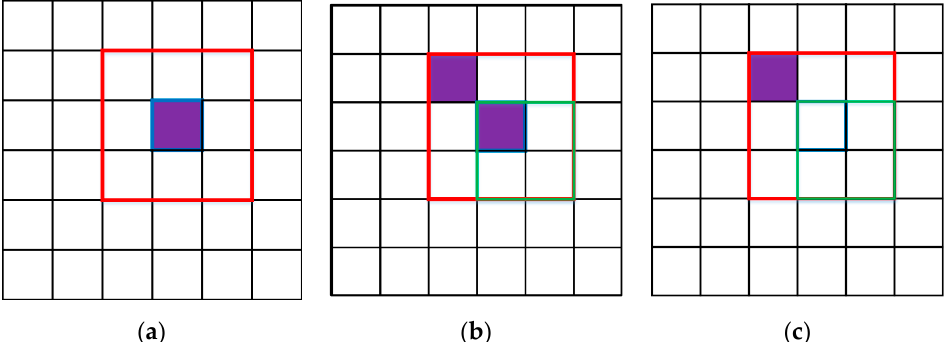
Figure 1. Analysis between the center test pixel and neighboring pixels in a single local window. The purple squares represent anomalous pixels, and the white squares represent the same category background pixels: ( a ) ideal distribution of neighboring pixels; ( b ) the neighborhood contains anomalous pixels; ( c ) the center pixel is a background pixel.